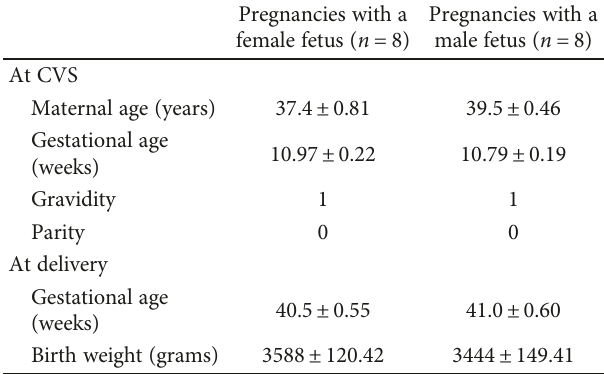
Mean ± SEM: chorionic villus sampling; CVS: characteristics were compared between groups using Mann – Whitney U test with Bonferroni multiple comparison